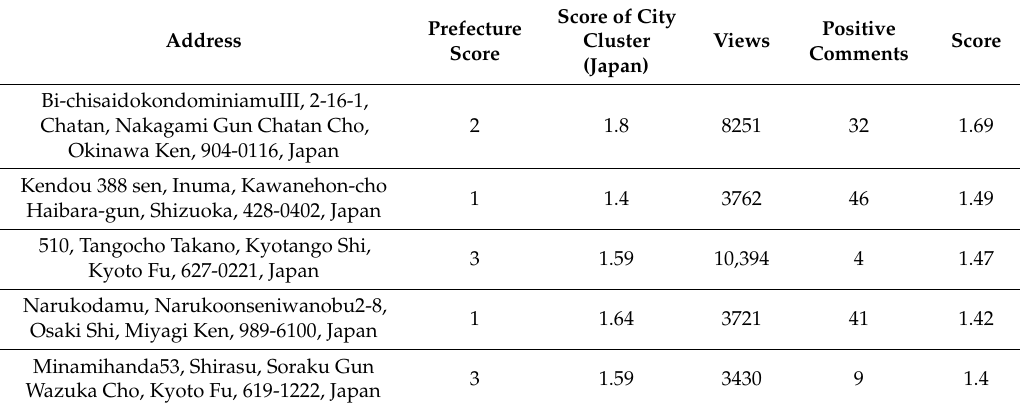
Table 10. Top 5 Japanese ranking